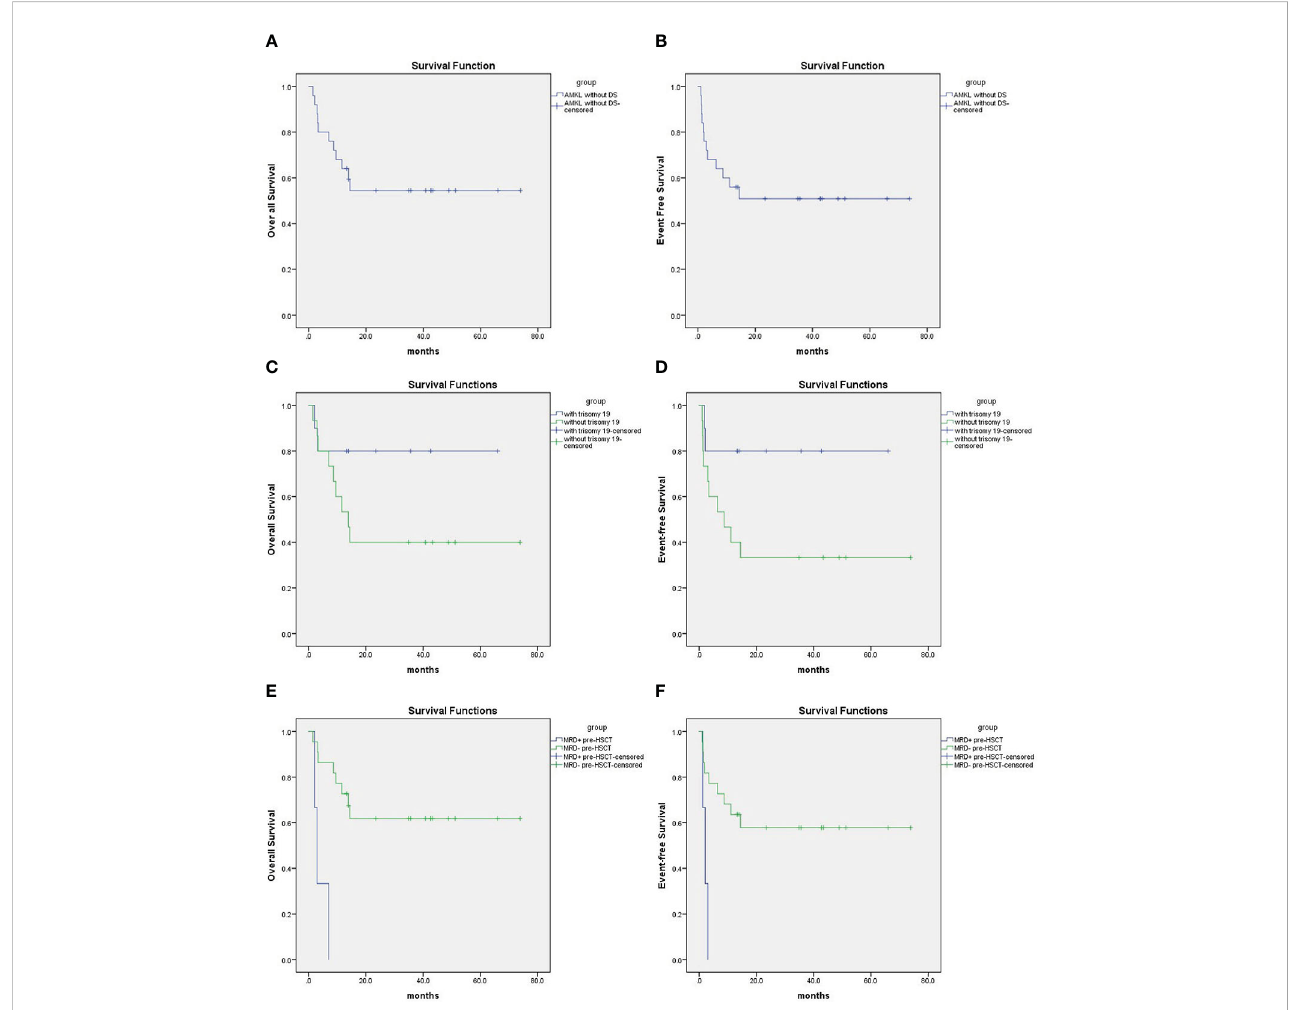
FIGURE 1 (A) 2-year Overall survival was 54.5 ± 10.3% for pediatric AMKL without DS undergoing haplo-HSCT; (B) 2-year event free survival was 50.9 ± 10.2% for pediatric AMKL without DS undergoing haplo-HSCT. (C) 2-year Overall survival was 80 ± 12.6% for patients with trisomy 19 and 40 ± 12.6% without trisomy 19 in pediatric AMKL without DS undergoing haplo-HSCT( P =0.114). (D) 2-year Event-free survival was 80 ± 12.6% for patients with trisomy 19 and 33.3 ± 12.2% without trisomy 19 in pediatric AMKL without DS undergoing haplo-HSCT( P =0.045). (E) 2-year Overall survival was 61.9 ± 10.7% for patients with MRD negative pre-HSCT and 0 with MRD positive pre-HSCT in pediatric AMKL without DS undergoing haplo-HSCT( P <0.001). (F) 2-year Event-free survival was57.9 ± 10.8% for patients with MRD negative pre-HSCT and 0 with MRD positive pre-HSCT in pediatric AMKL without DS undergoing haplo-HSCT ( P